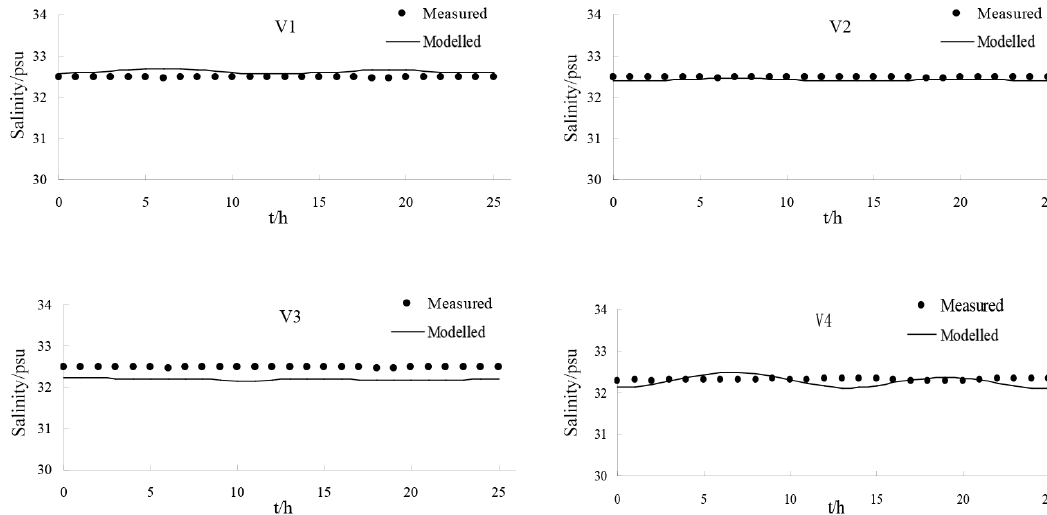
Figure 9. The validation of salinity measured at stations during spring tide.